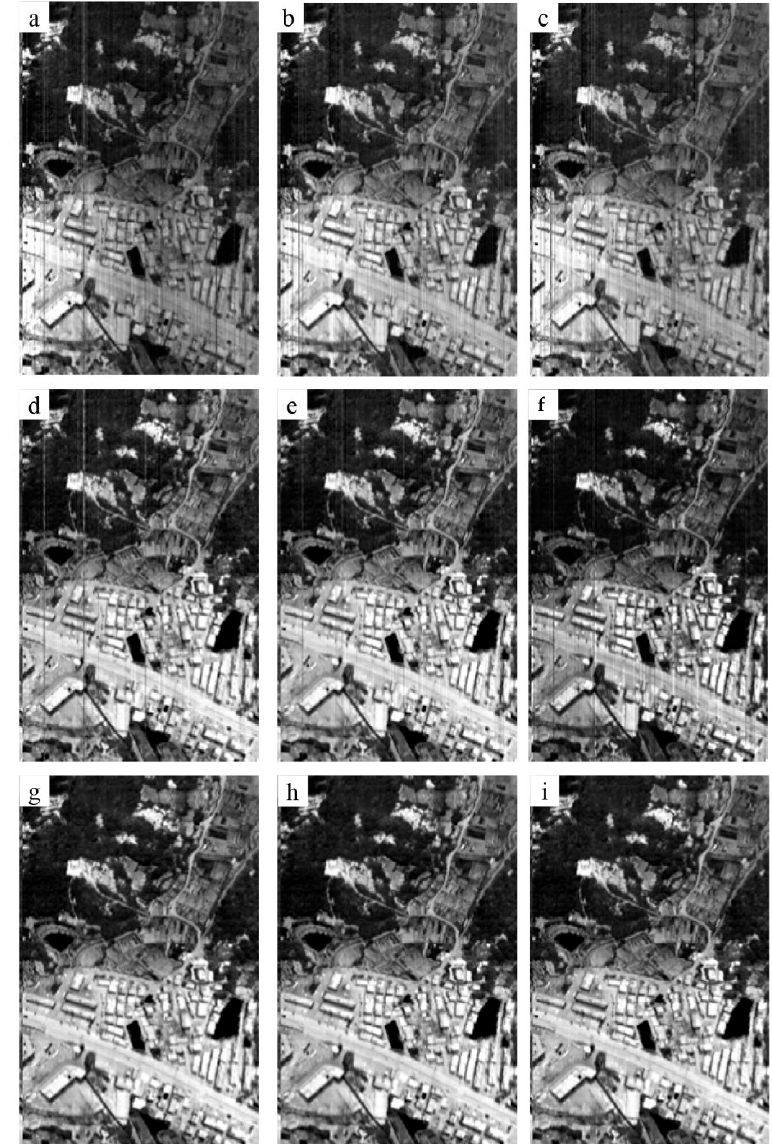
Figure 10. The temperature retrieved by the commonly used TES algorithms based on the ATHIS data before ( a – c ) blind pixel repair, ( d – f ) blind pixel repair by GB/T 17444-2013 method and ( g – i ) blind pixel repair by the proposed method. ( a , d , g : ARTEMISS; b , e , h : WTTES; c , f , i : RDSS.). The influence of the blind pixel on the inversion result is not only the strip noise on the image but also the peak of the emissivity spectrum and the overall deviation of the emissivity value in the spectral dimension. Figure 11 shows the emissivity spectrum of roads and roofs on the result image. The emissivity value deviates, and its corresponding temperature also deviates greatly from the true value (the emissivity is theoretically between 0 and 1). Although the spikes in Figure 11a can be removed by spectral filtering in the post-processing of the results, the deviation of emissivity cannot be corrected. From this point of view, under the current inversion technology, repairing blind pixel is crucial for the inversion of temperature and